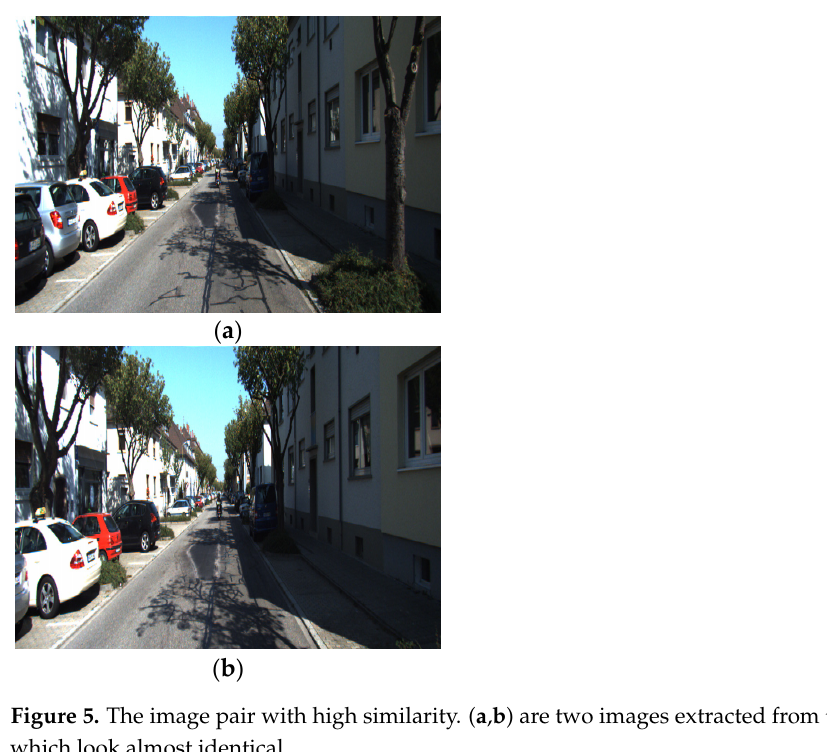
Figure 5. The image pair with high similarity. ( a , b ) are two images extracted from the video stream, which look almost identical.